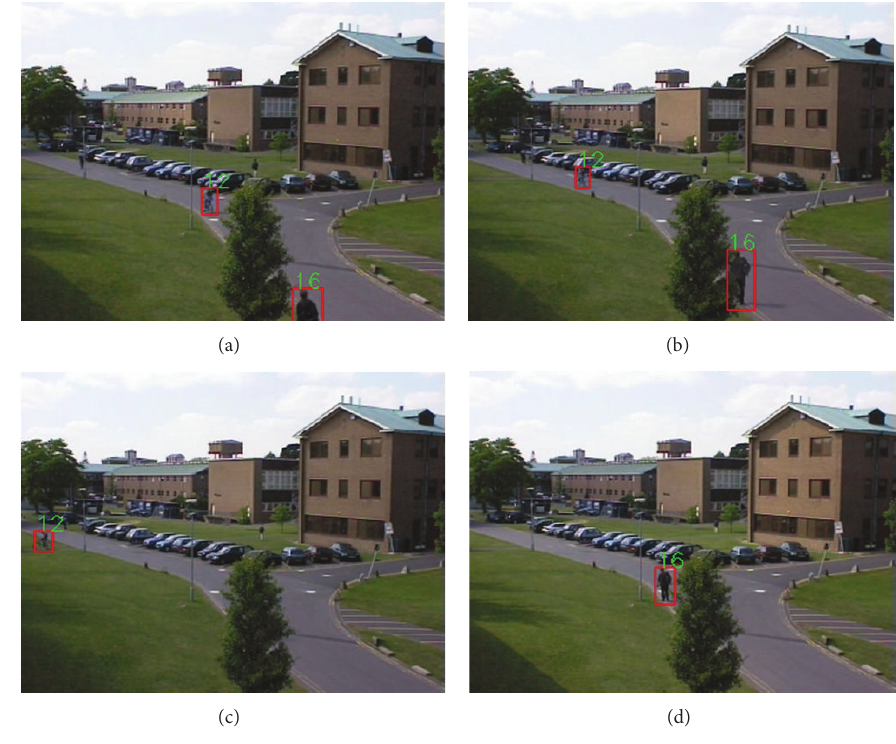
Figure 4: The target tracking results of video data 1.